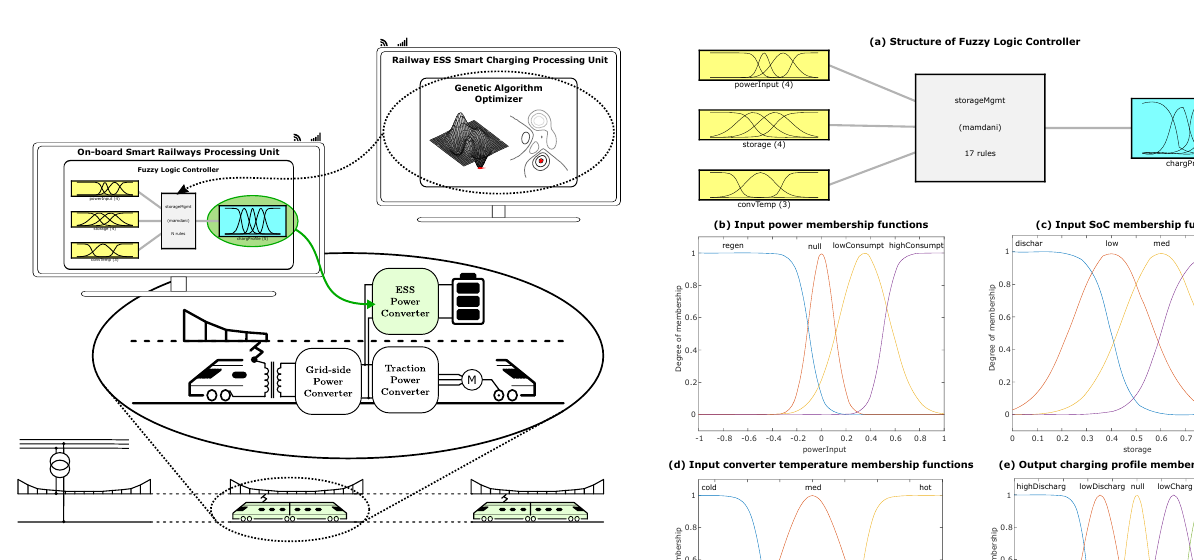
Figure 4. Integration of FLC + GA charging strategy with the train on-board ESS hardware.